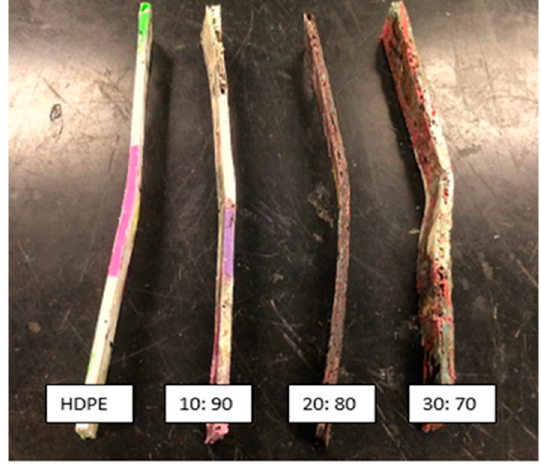
Figure 6. Bending failures of WOC with different ratios of HDPE and wood powder.